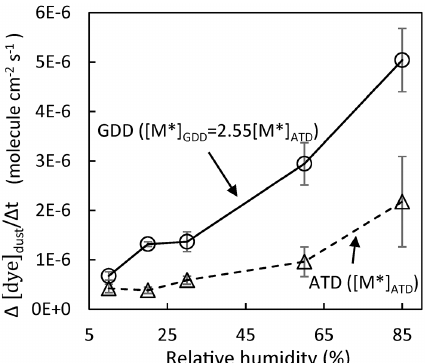
Figure 3. The dye degradation rate in the presence of ATD or GDD particles measured using a UV flow chamber under RH levels rang- ing from 10% to 85%. As a control, the photodegradation of mala- chite green in the absence of dust was measured, but the degradation was negligible. The error bars represent the standard